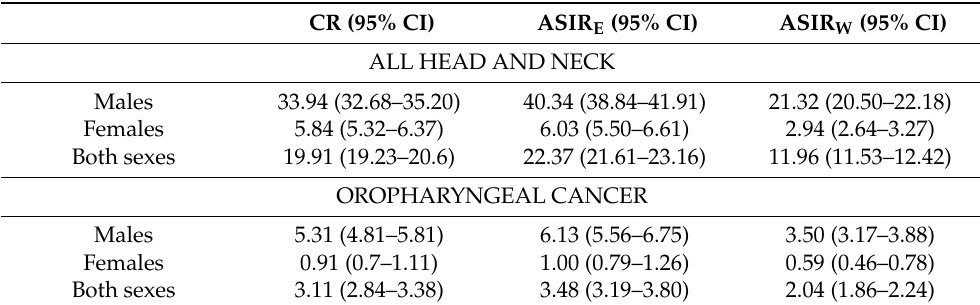
Table 1. Incidence rates of overall head and neck cancer and oropharyngeal cancer between 1994 and 2018 according to